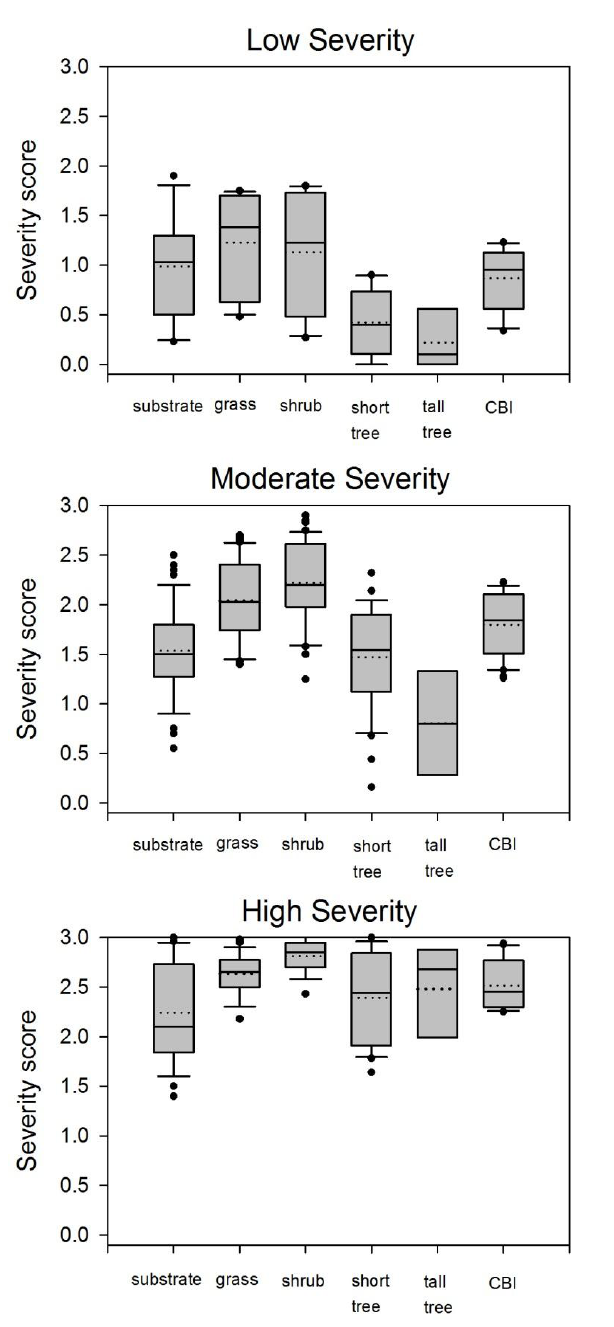
Figure 3. Box plots summarizing stratum scores and total plot CBI scores by severity class. Severity classes are determined by measured CBI scores of plots. The boundary of the box closest to zero indicates the 25th percentile, the line within the box marks the median, and the boundary of the box farthest from zero indicates the 75th percentile. Whiskers (error bars) above and below the box indicate the 90th and 10th percentiles. Means are represented by the dotted